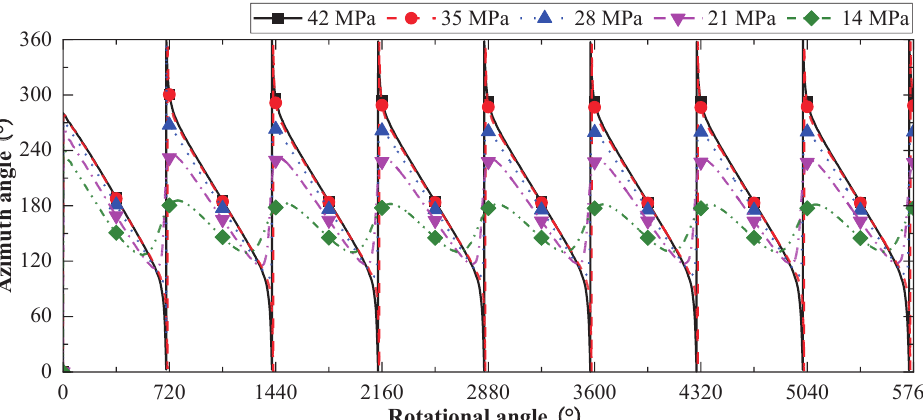
Figure 23. Overturning azimuth angle of cylinder block.